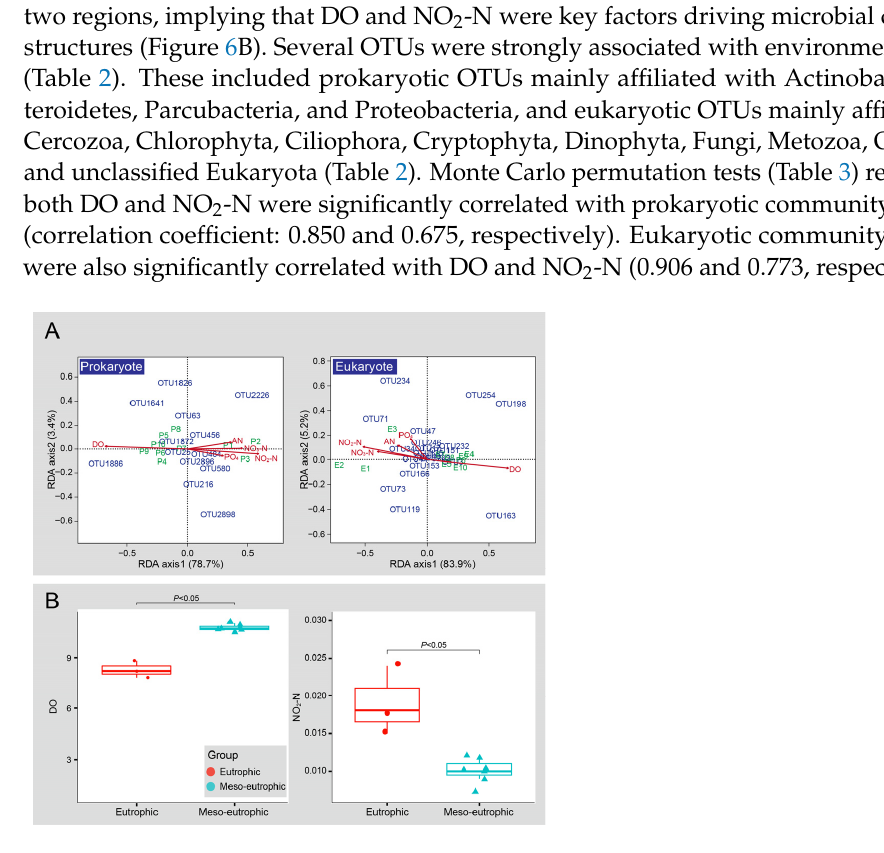
Figure 6. RDA ordination showing the prokaryotic and eukaryotic community structures, respectively ( A ). DO, dissolved oxygen; NO 3 -N, nitrate nitrogen; NO 2 -N, nitrite nitrogen; AN, ammonia